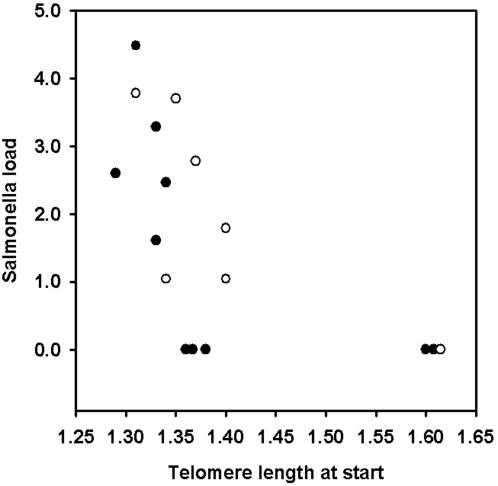
Initial telomere length and Salmonella load at termination.Relative telomere lengths (T/S ratio) at the start in WBCs from females (indicated with filled circles; N = 10) and males (open circles; N = 7) predicted Salmonella loads (log10 colony forming units/ml of spleen) at the end of the experiment.